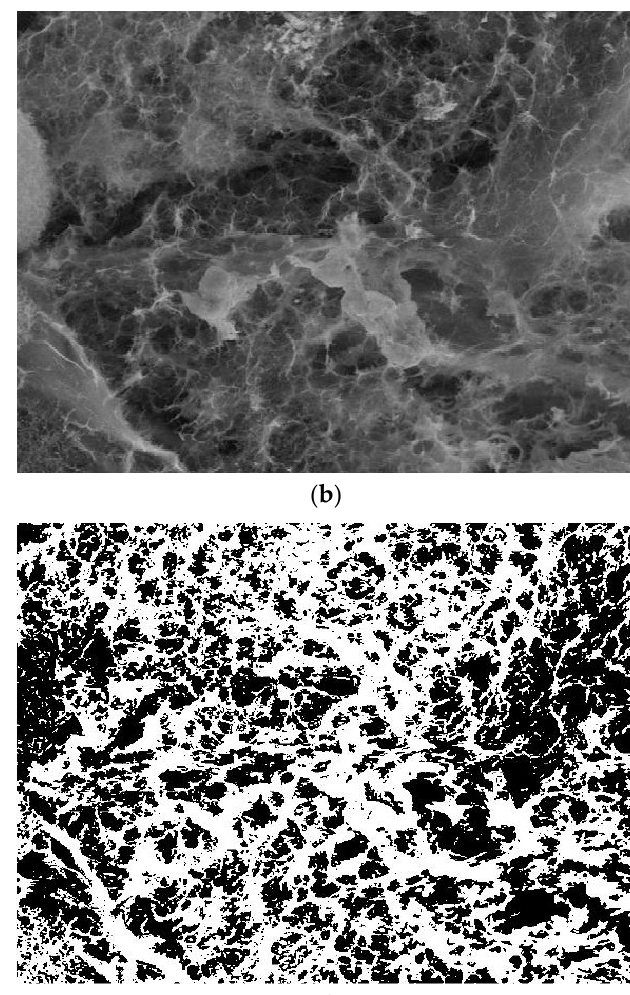
( f ) Figure 9. Fractal investigation of image B: ( a ) Black and white version of image B, ( b ) Grayscale